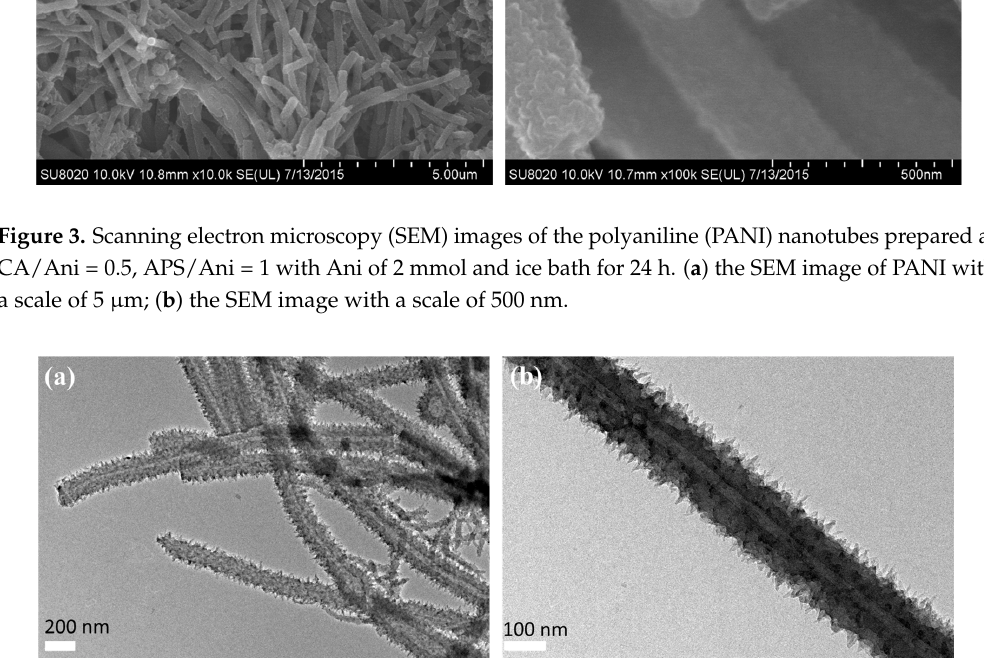
Figure 4. Transmission electron microscopy (TEM) images of the PANI nanotubes prepared at CA/Ani = 0.5, APS/Ani = 1 with Ani of 2 mmol and ice bath for 24 h. ( a ) the TEM image of PANI with a scale of 200 nm; ( b ) the TEM image with a scale of 100 nm.